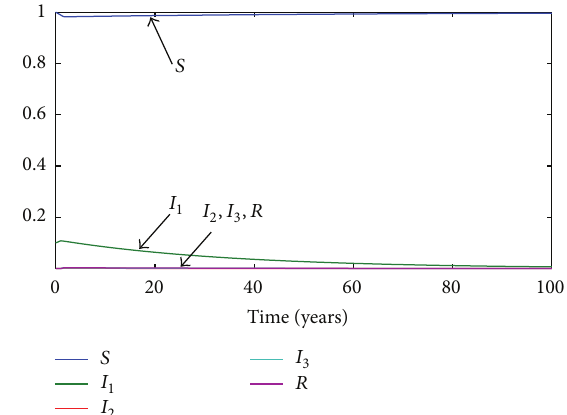
Figure 4: Dynamic of the subpopulations for 𝑅 0 = 0.5 .